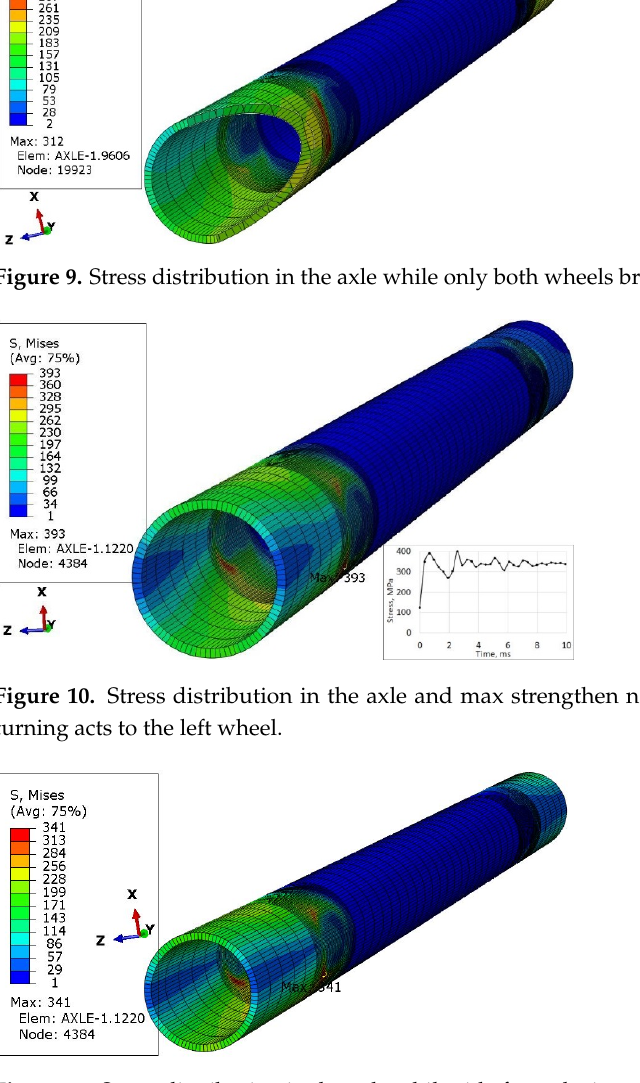
Figure 11. Stress distribution in the axle while side force during turning acts to both